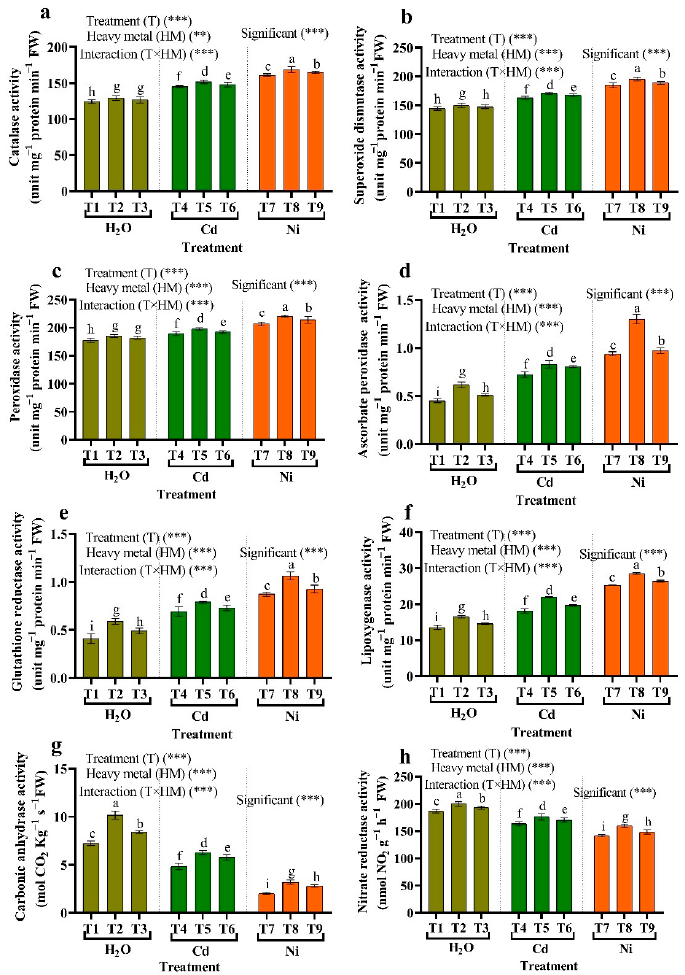
Figure 6. The influence of two endophytic bacteria on ( a ) catalase, ( b ) superoxide dismutase, ( c ) peroxidase, ( d ) ascorbate peroxidase, ( e ) glutathione reductase, ( f ) lipoxygenase, ( g ) carbonic anhydrase and ( h ) nitrate reductase activity in tomato plants growing under HM stress. Fisher’s test at p < 0.05 reveals significant variations in means (±standard error) of different letters (a–i) on the same bars. Thus, ** and *** imply significance levels of 0.01 and 0.05, respectively. T1: (Control with tap water), T2: Micrococcus luteus , T3: Enterobacter cloacae , T4: 50 μ M Cd, T5: Micrococcus luteus + 50 μ M Cd, T6